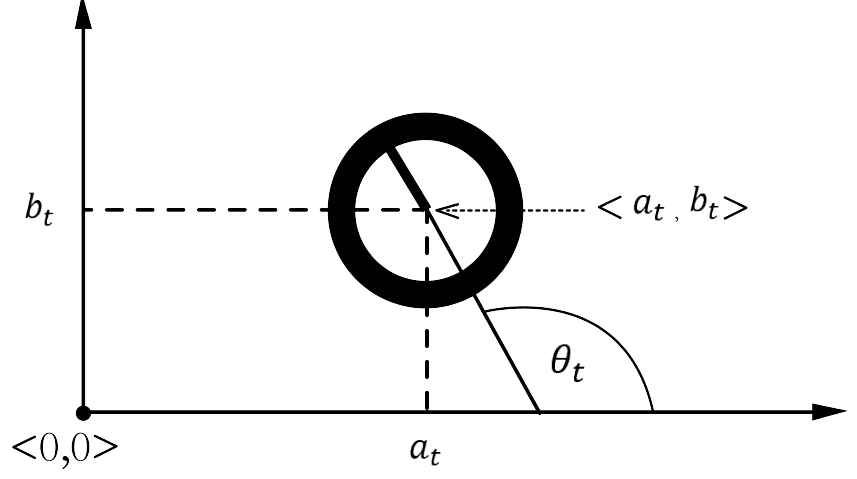
Figure 1. Target’s Cartesian